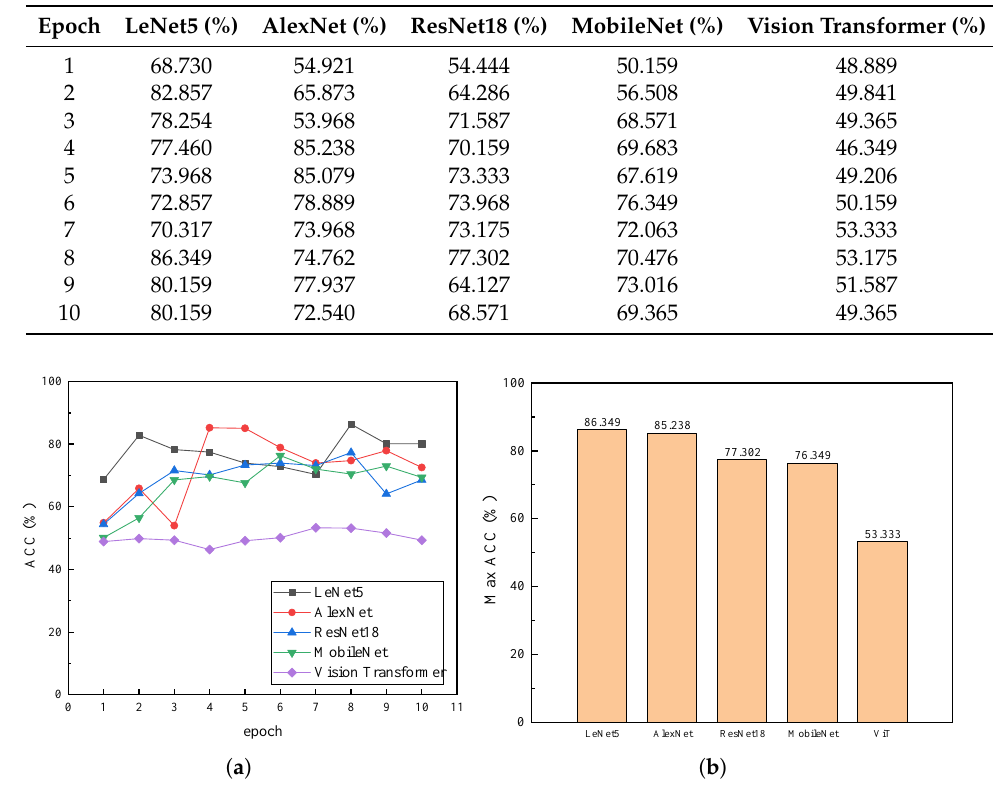
Figure 4. Comparison of accuracy before data augmentation and before GPU loading. ( a ) Comparison of accuracy of each model before data augmentation and before GPU loading. ( b ) Histogram comparing the highest accuracy of each model before data augmentation and before GPU